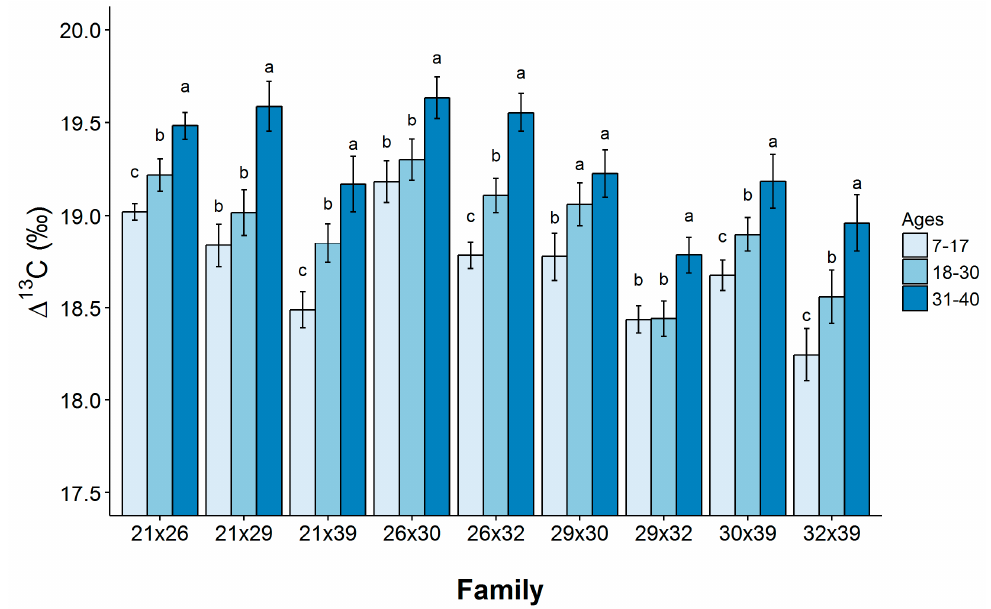
Figure 5. Mean ∆ 13 C (‰) values tend to increase from early to late growth stages within families. Means with the same letter within each family are not significantly different from each other as indicated by Tukey HSD post-hoc test ( α = 0.05).